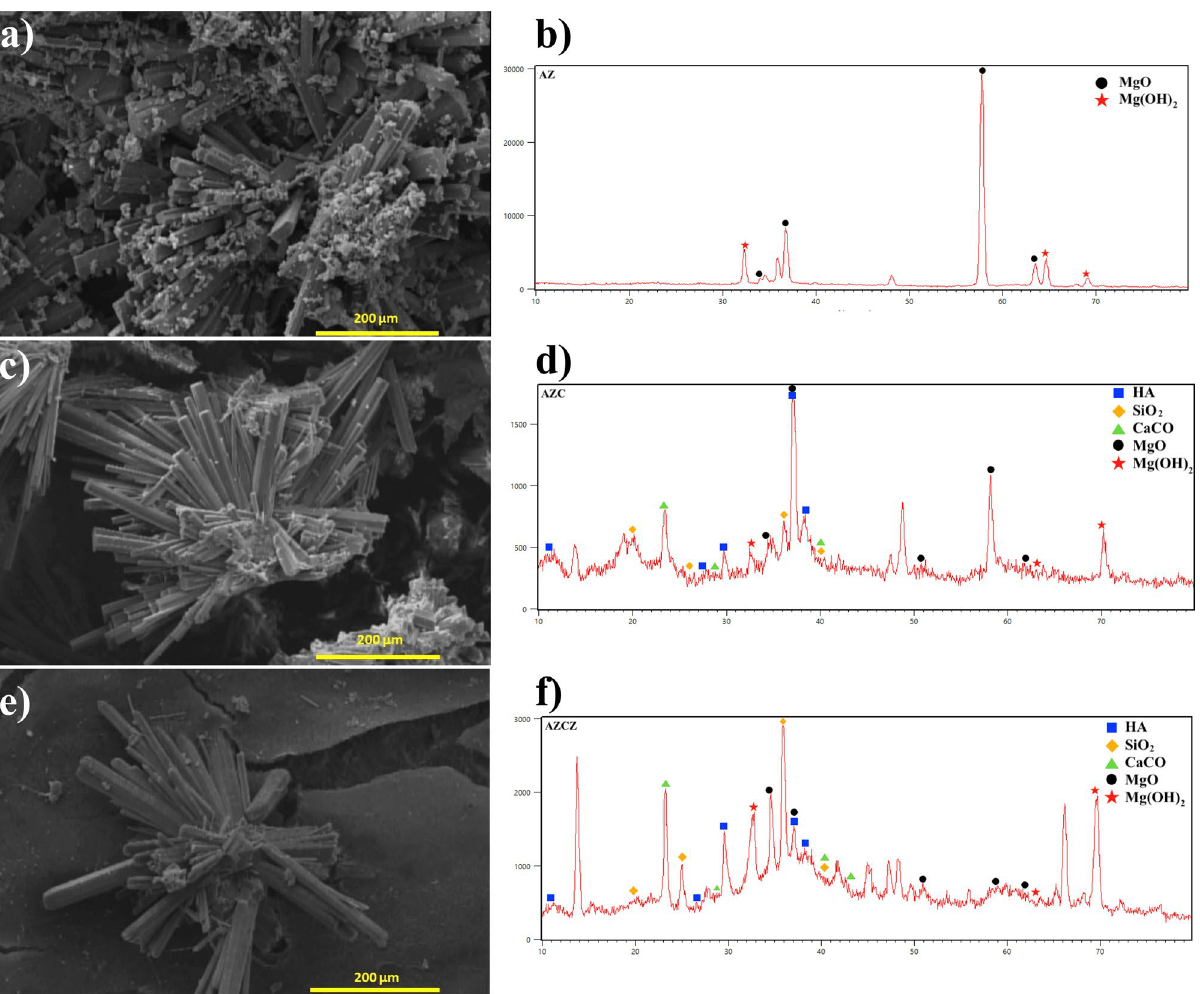
Figure 4. Products of biodegradation formed the surface of magnesium alloy in SBF at 37 °C after 15 days. SEM images and XRD patterns are for ( a , b ) AZ, ( c , d ) AZC, and ( e , f ) AZCZ